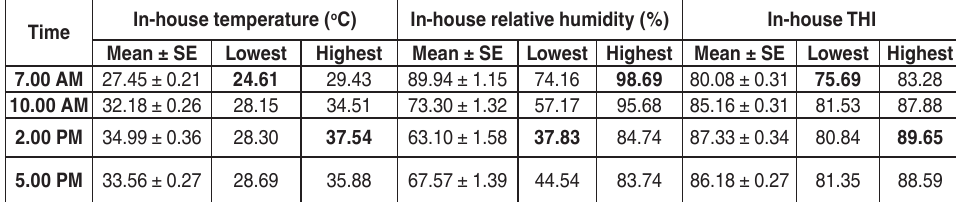
table 3. Mean ± SE of TEC, TLC and Hb of Malabari, crossbred and Attappady black goats Day of thi study